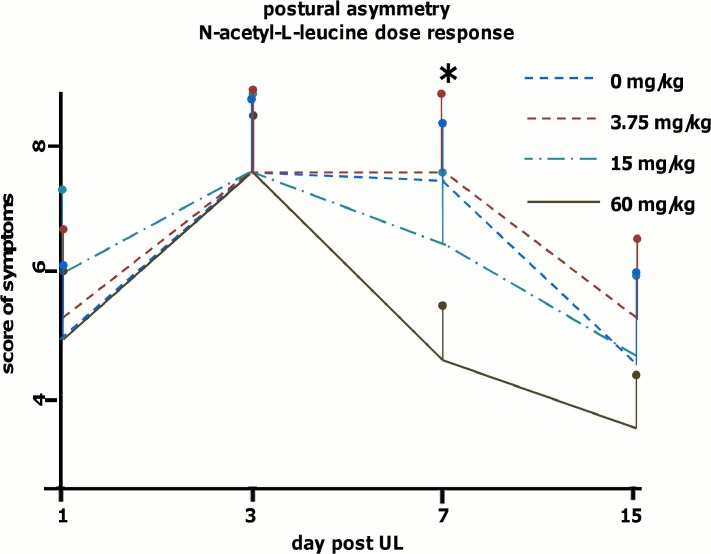
Dose-dependent effects of N-acetyl-L-leucine on postural compensation after unilateral labyrinthectomy.Sham treatment (vehicle) and N-acetyl-L-leucine (3.75, 15 or 60 mg/kg) was administered i.v. on days 1, 2 and 3 (six animals per group). Postural imbalance scores were analyzed in all groups on days 1, 3, 7 and 15. Postural imbalance was significantly decreased in the 60 mg/kg (p<0.004) but not in the 15 mg/kg or 3.75 mg/kg group. Values are depicted as mean, the standard deviation as error bars. Significant values (60 mg/kg vs. vehicle and 60 mg/kg vs. 3.75mg at day 7) are marked with an asterisk.